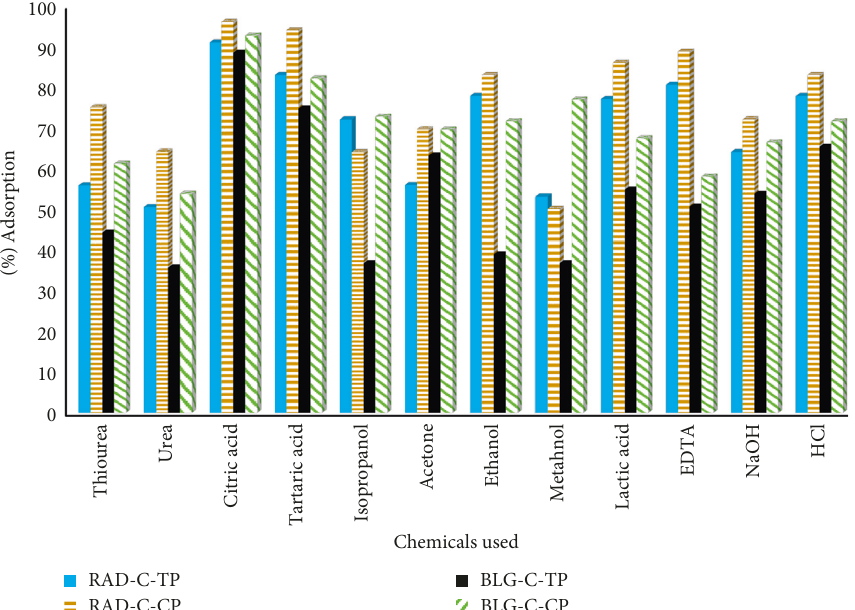
Figure 4: A comparative study of adsorption of dyestuffs after chemical modification with different modifying agents.